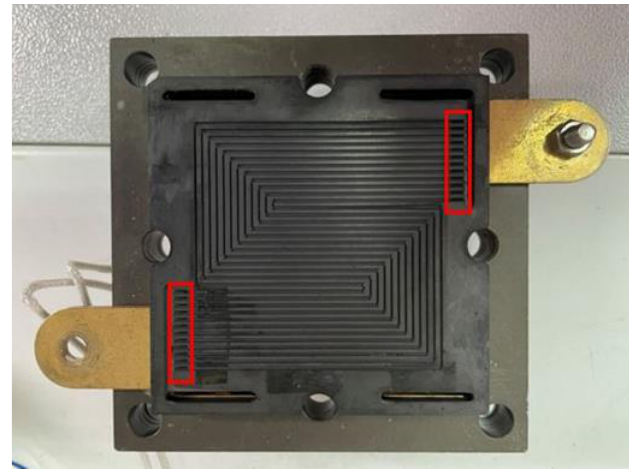
Figure 8. Graphite serpentine runner plate.